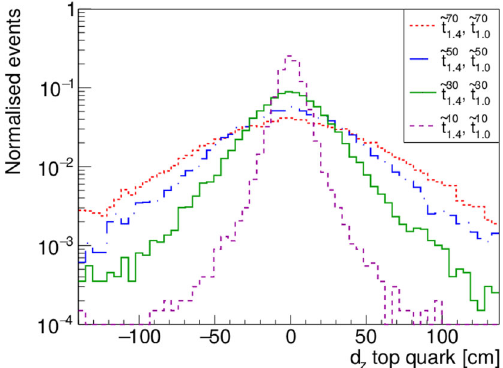
Fig. 54 Total transverse hadronic energy in the stop squark ˜ t case